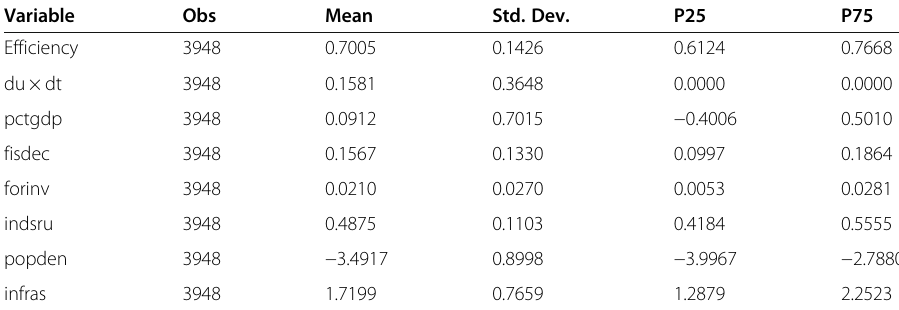
Table 2 Descriptive statistics of the variables